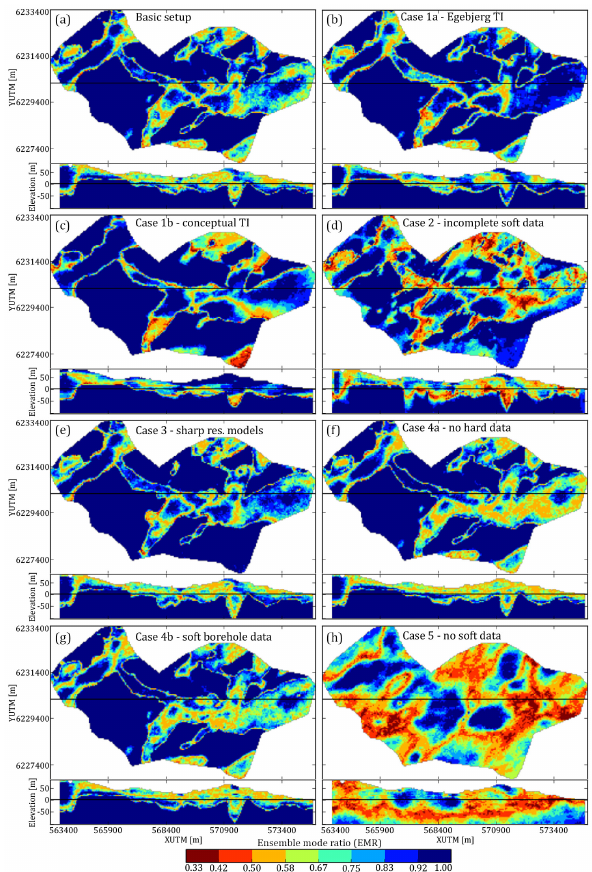
Figure 10. A presentation of the ensemble mode ratio (EMR) maps, computed for the different case ensembles of hydrostratigraphic models. Each EMR map is presented as a horizontal slice centered on 20mb.s.l. and a vertical cross section intersecting at YUTM 6230150m. (a–h) present the EMR-type uncertainty map for each of the different cases, which are summarized in Table 1. The EMR values portray how certain the ensemble of MPS realizations are; i.e., if r EMR = 1 / 3 then the realization is uncertain, and we have equal probability of finding either hydrostratigraphic unit since P(s 1 ) = P(s 2 ) = P(s 3 ) = 33%. On the other hand, if r EMR = 1, then each realization of the given ensemble contains the same hy- drostratigraphic unit at the given grid